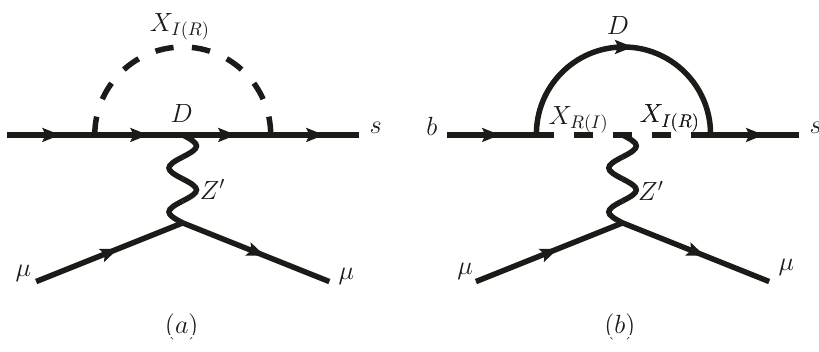
Figure 1 . Z 0 -exchanging penguin diagrams generating b